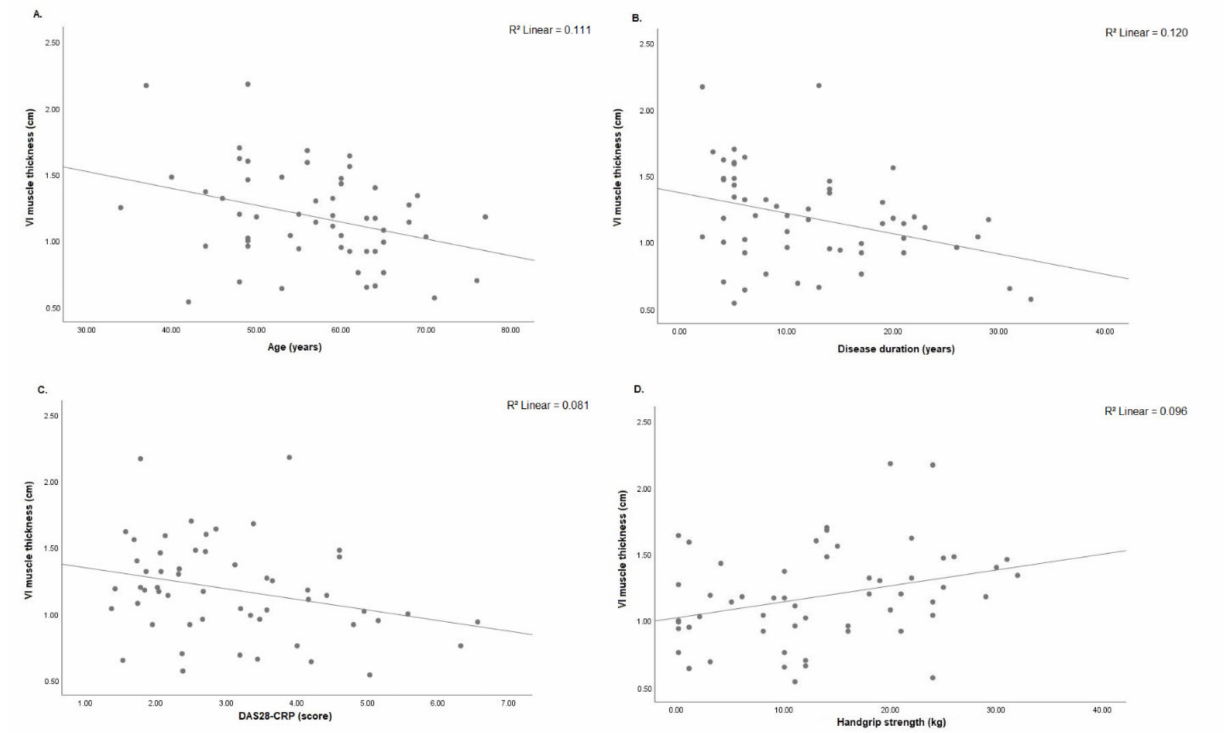
Figure 4. ( A ) Correlation analysis was significant between RF muscle thickness and age ( n = 55, r = − 0.503; p < 0.001), ( B ) disease duration ( n = 55, r = − 0.493; p < 0.001), ( C ) chair stand test ( n = 32, r = − 0.368; p = 0.038) and ( D ) handgrip strength ( n = 55, r = 0.325; p = 0.015). RF: rectus femoris; cm: centimeters; 5-reps: five repetitions; kg: kilograms.